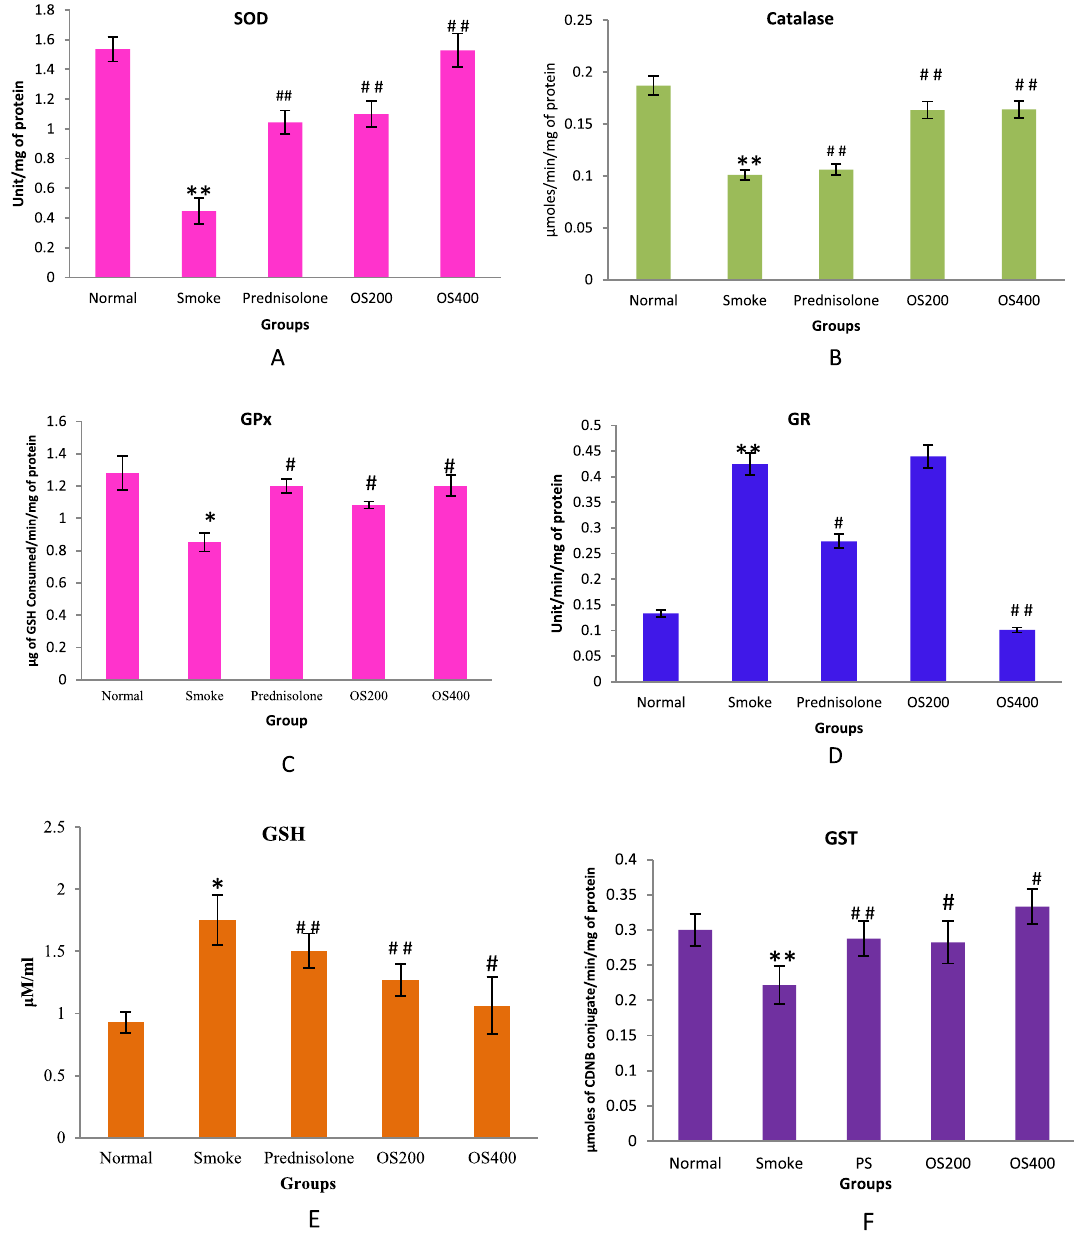
Figure 5. OLE reverted SOD ( A ), Catalase ( B ), GPx ( C ), GR ( D ), GSH ( E ) activity and GST content ( F ) in CS exposed mice: The modulated activity of SOD, catalase, GPx, GR and GST in CS − induced mice was reverted with the administration of OLE with 200 mg/kg and 400 mg/kg. The increased content of GSH in CS − induced mice was effectively decreased with the administration of OLE 200 mg/kg and 400 mg/kg. Values are